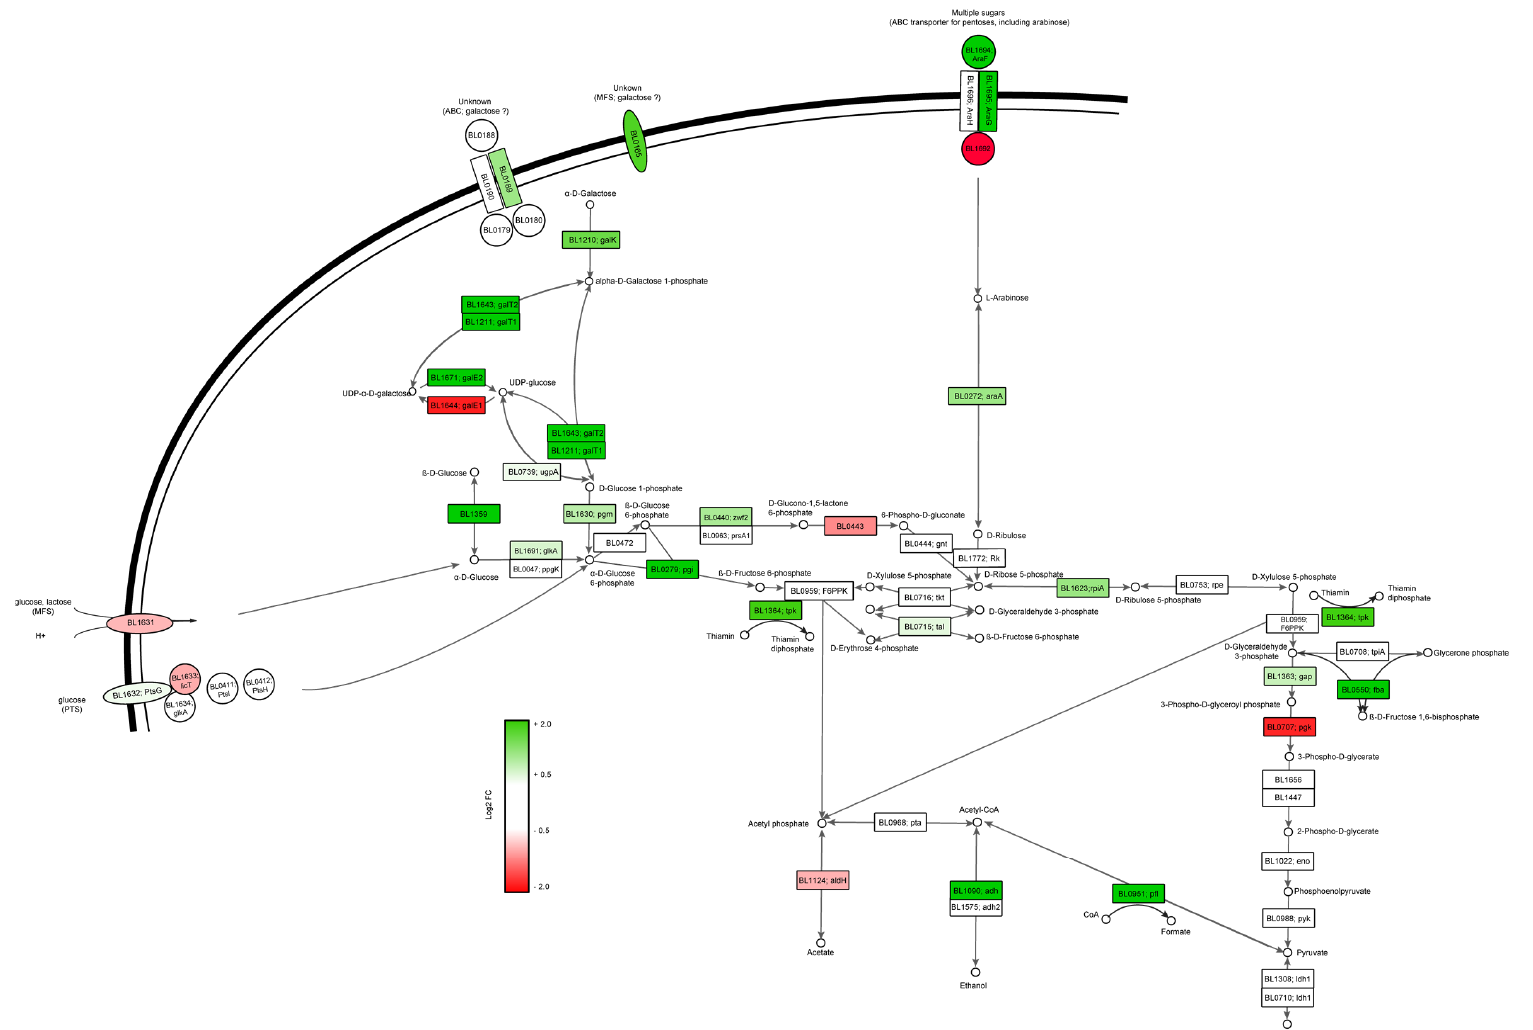
Figure 3. Differential expression of genes related to carbohydrate import and central carbon metabolism of B. longum NCC 2705 grown on galactose or glucose. Color scale represent log2 fold change in galactose:glucose (green) or glucose:galactose (red).